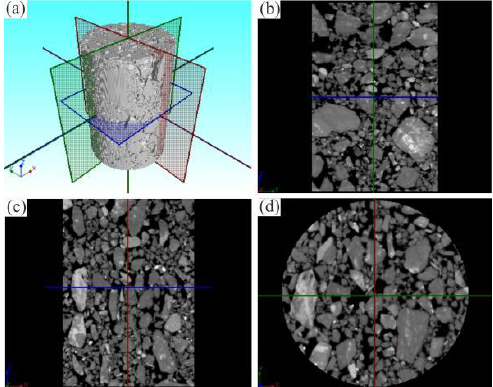
Figure 9. CT scanning of standard cylinder. ( a ) 3D model of standard cylinder. ( b ) X-section. ( c ) Y-section. ( d ) Z-section.